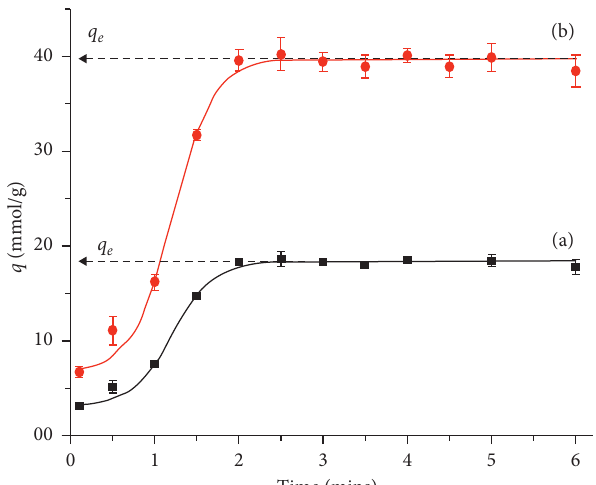
Figure 10: Kinetic studies for fluoride sorption from aqueous solutions by layered rare-Earth hydroxides: (a) LEuH-Cl aggregates; (b) LEuH-flocs nanosheets. q e maximum adsorbed amount; pH � 7, temperature � 298K, and mass of sorbent �